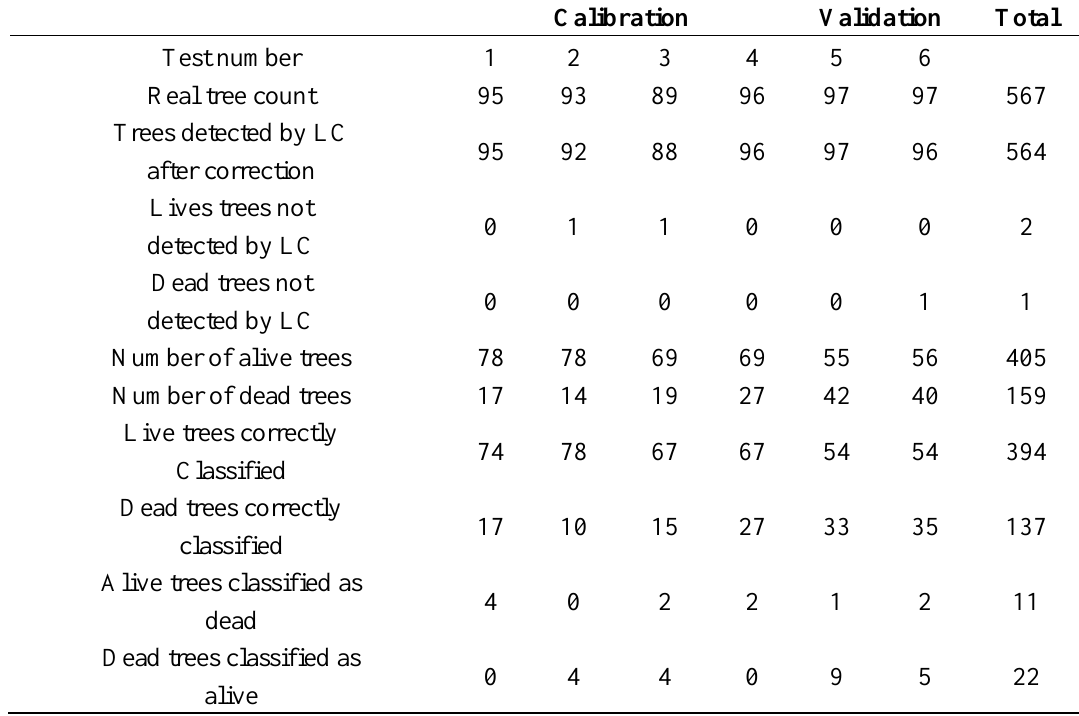
Table 14. Light curtain results obtained for the tree classification with the calibration and validation samples using the parameter values selected the in calibration (dead range of 50 and threshold count of 21.4).